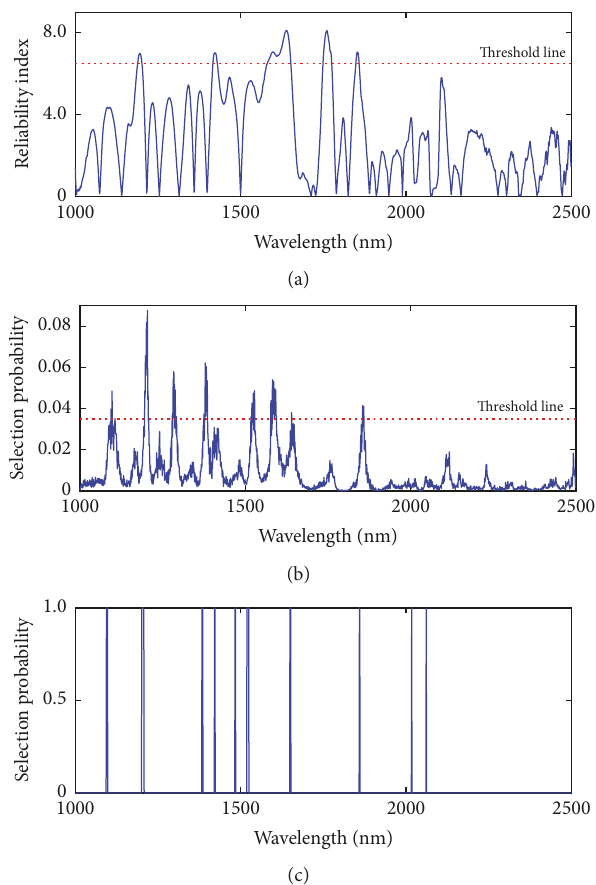
Figure 5: Results of variable screening of lipid dataset by (a) MC- UVE, (b) RF, and (c)